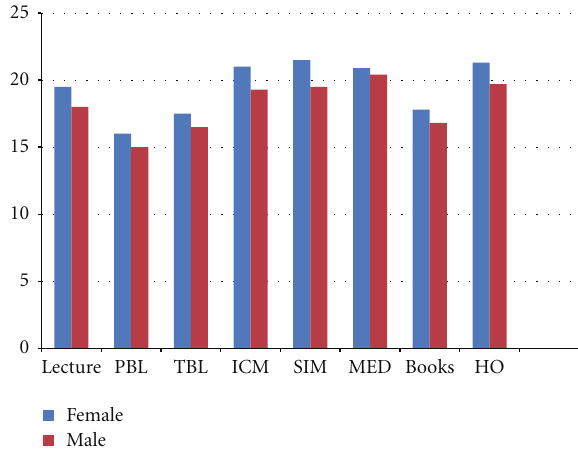
Figure 4: Male-female di ff erences for